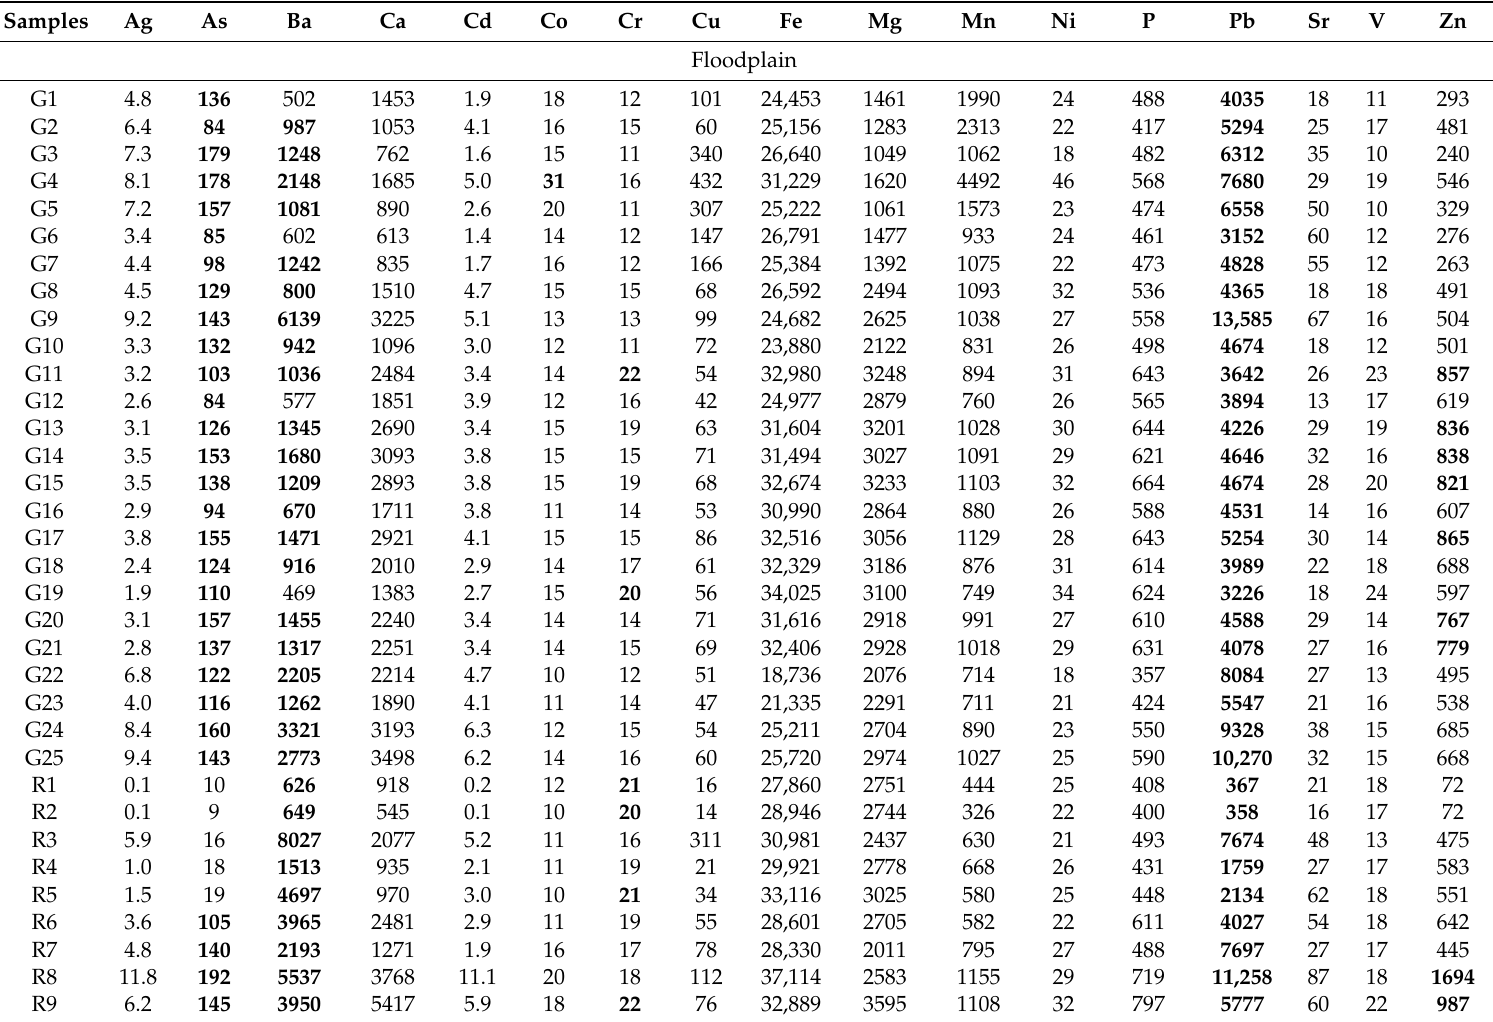
Table 1. Total concentrations (mg / kg) of selected elements in the sediment samples. Concentrations above the reference values are in bold.